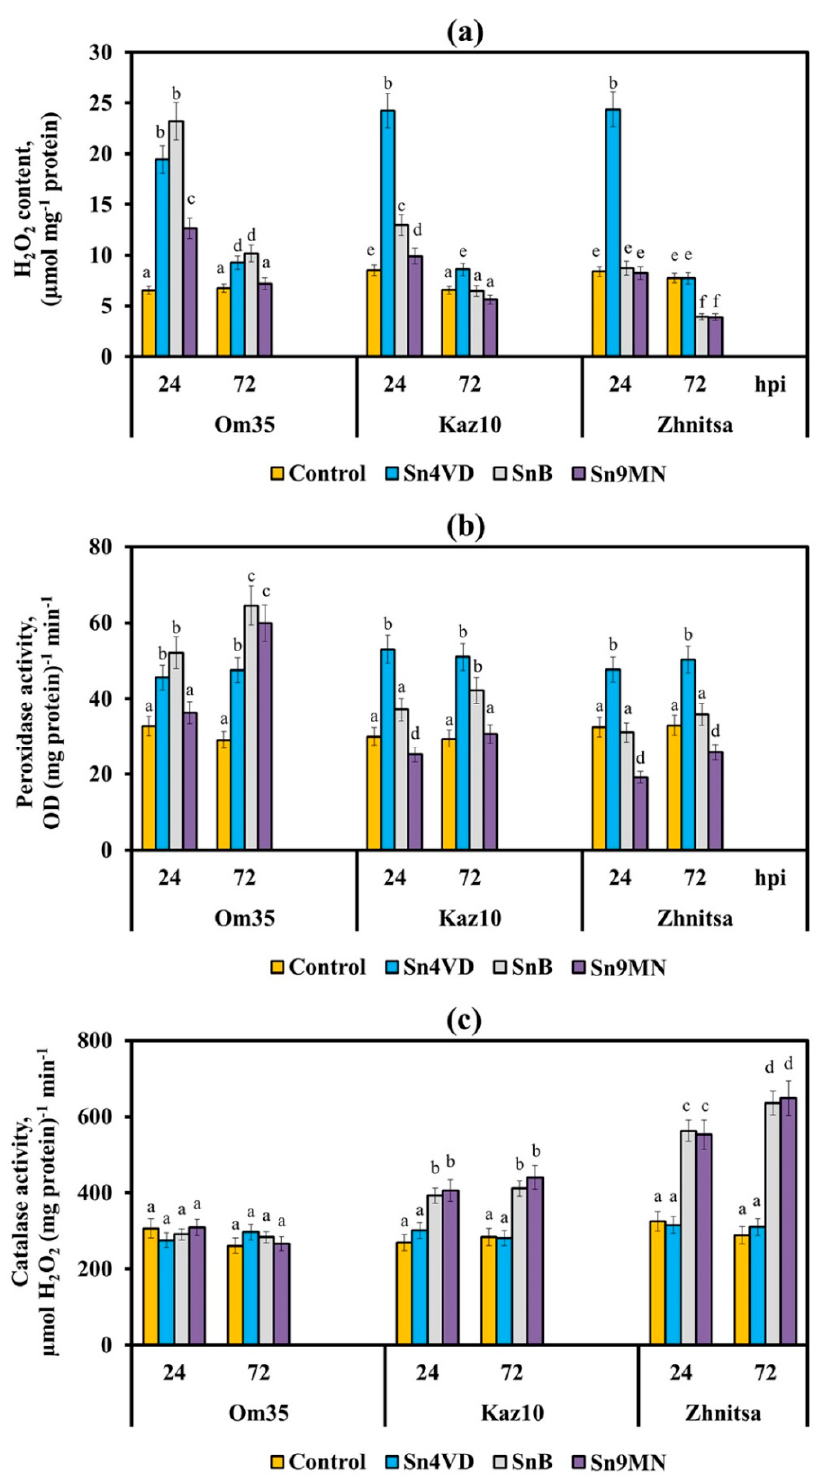
Figure 4. Hydrogen peroxide contents ( a ), enzymes activities of peroxidase ( b ) and catalase ( c ) in leaves of wheat cultivars Om35, Kaz10 and Zhnitsa 24 and 72 h post-inoculation (hpi) with S. nodorum isolates Sn4VD, SnB and Sn9MN. The samples are indicated as follows: Control—non-infected plants; Sn4VD—plants infected with isolate Sn4VD; SnB—plants infected with isolate SnB; Sn9MN—plants infected with isolate Sn9MN. Means ± SE (n = 6) marked with similar Latin letters do not differ significantly according to the LSD-test ( p ≤